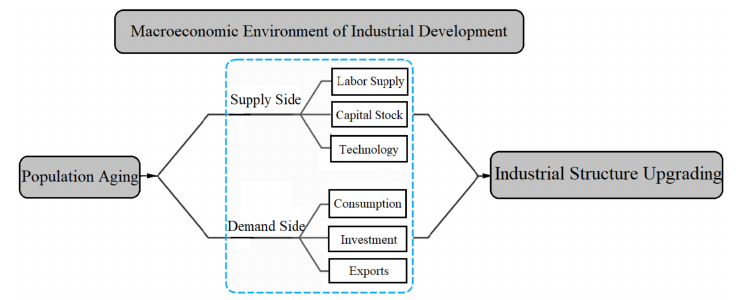
Figure 1. The Influencing Mechanism of Population Aging on Industrial structure